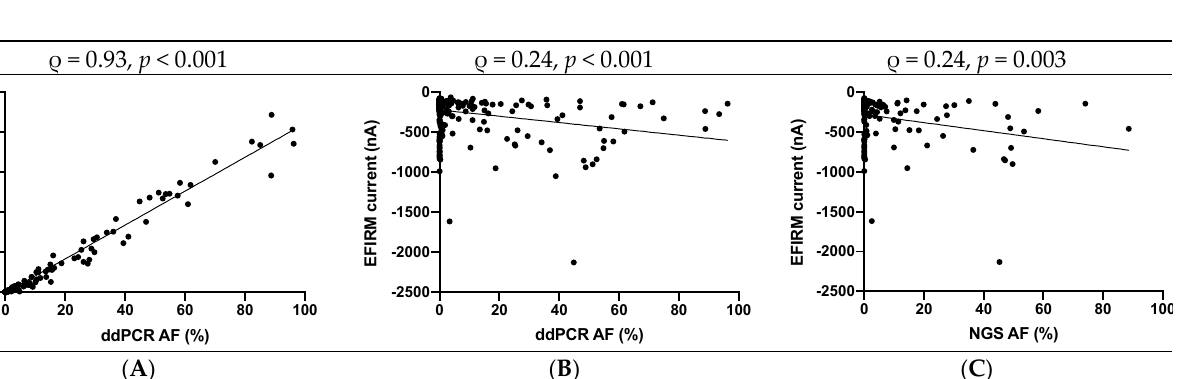
Figure 3. ( A-C ) Correlations between ddPCR, NGS, and EFIRM liquid biopsy (eLB) assays.